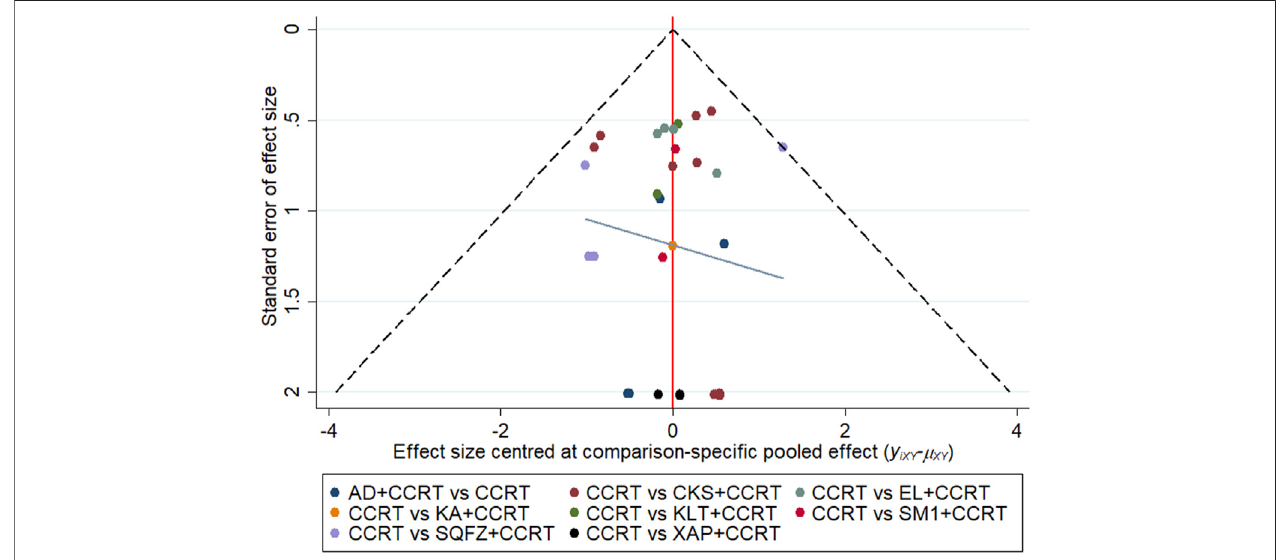
FIGURE 6 | Funnel plots ofclinical effective rate. Note: (AD, Aidi injection; CCRT, concurrent chemoradiotherapy; CKS, Compound Kushen injection; EL, Elemene injection; KA, Kangai injection; KLT, Kanglaite injection; SM1, Shengmai injection; SQFZ, Shenqifuzheng injection; SM2, Shenmai injection; and XAP, Xiaoaiping